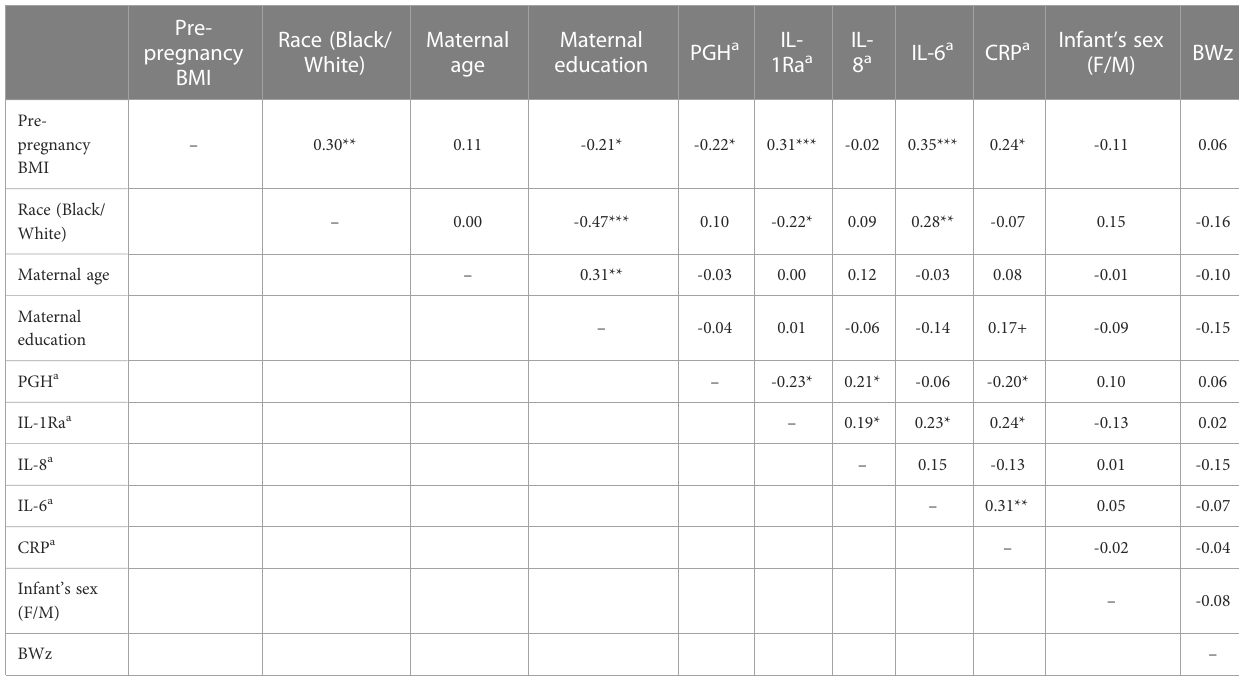
TABLE 2 Bivariate correlations between focal predictors among the full